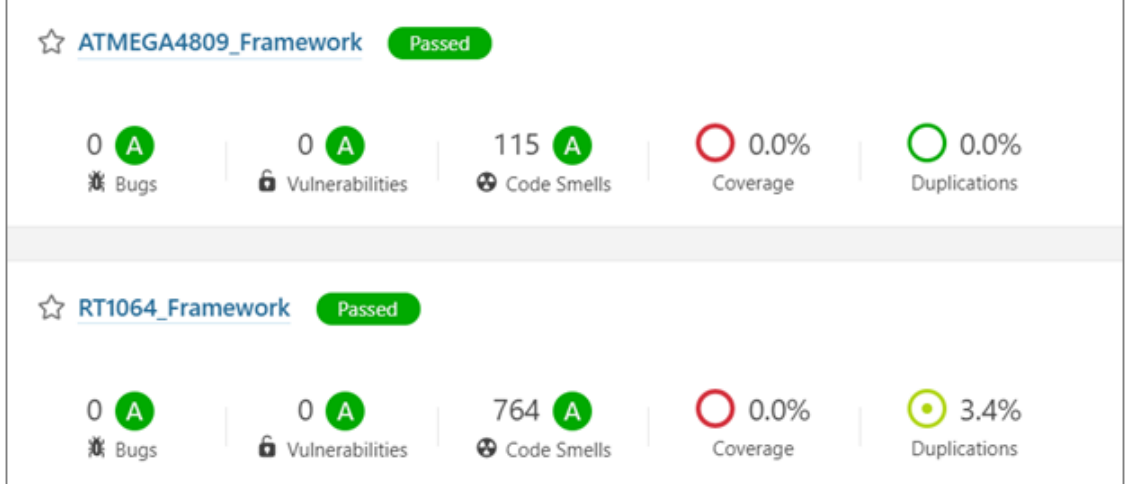
Figure 12. Static code analysis results using SonarQube for the 8-bit Microchip microcontroller (ATMEGA4809) and the 32-bit NXP microcontroller